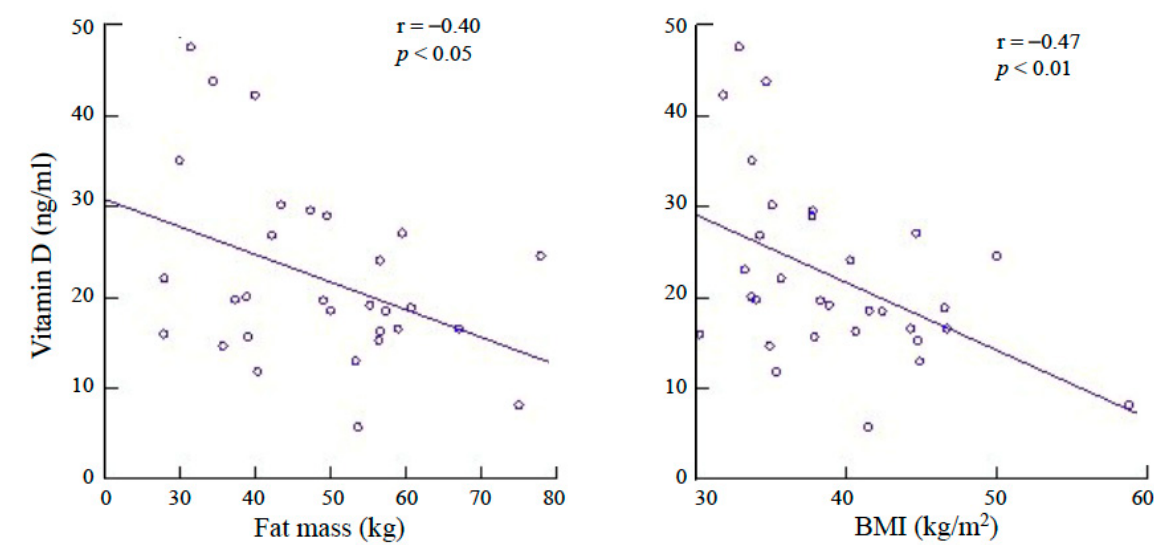
Figure 1. Correlations between the serum concentrations of 25-hydroxy vitamin D and fat mass (FM) and body mass index (BMI) in people with obesity.